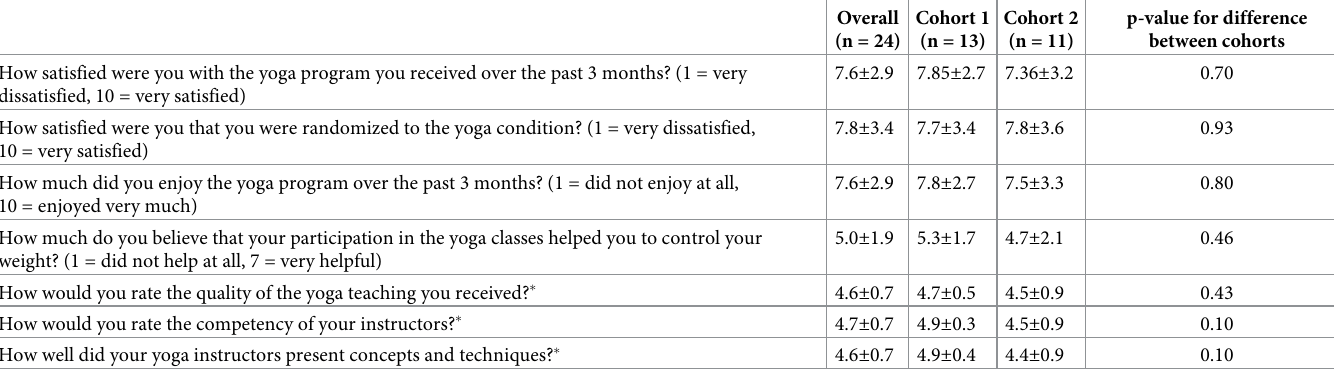
Table 2. Program satisfaction scores for YOGA